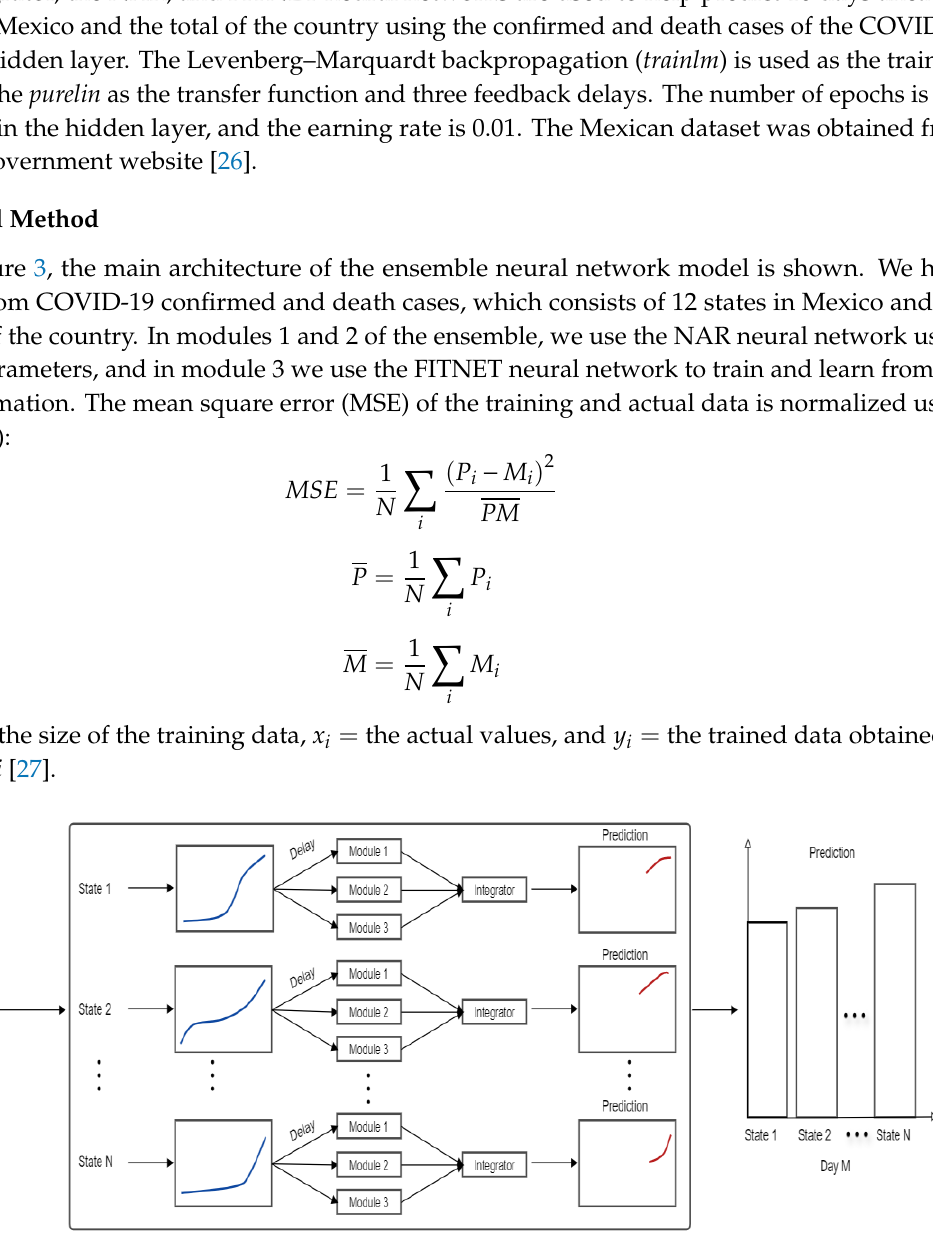
Figure 3. The main architecture of the system.